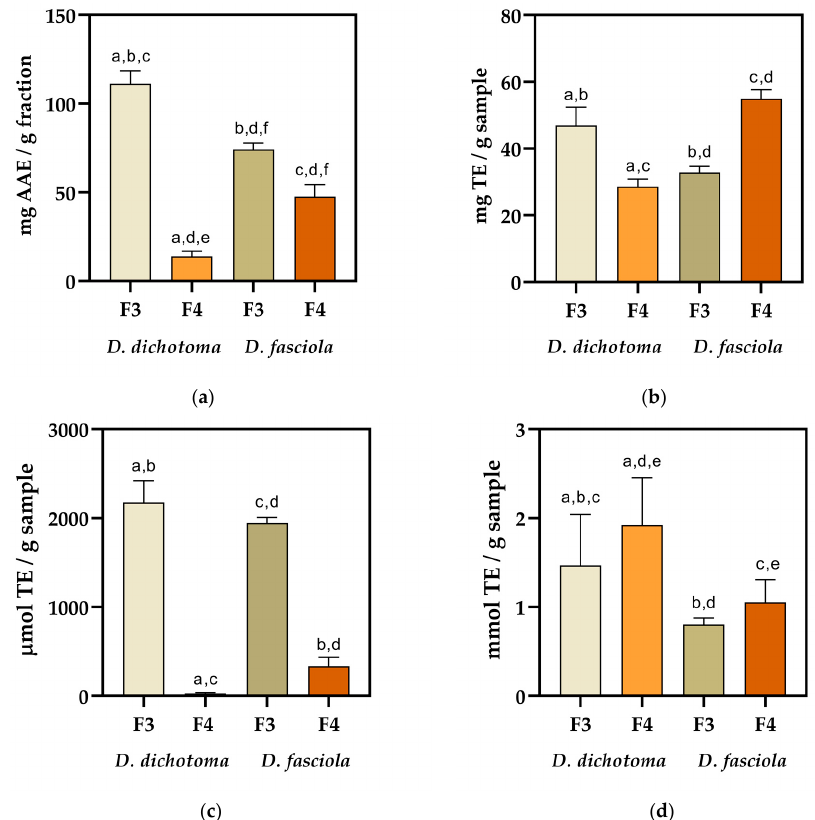
Figure 3. Radical scavenging effect of D. dichotoma and D. fasciola F3 and F4 fractions using ( a ) 2,2- diphenyl-1-picryl-hydrazyl-hydrate (DPPH), ( b ) reduction of radical cation (ABTS), ( c ) oxygen radical absorbance capacity (ORAC), and ( d ) ferric reducing antioxidant power (FRAP) in vitro assays (mean ± SD; n = 3). Common le tt ers indicate a signi fi cant di ff erence between the fractions ( p < 0.05).